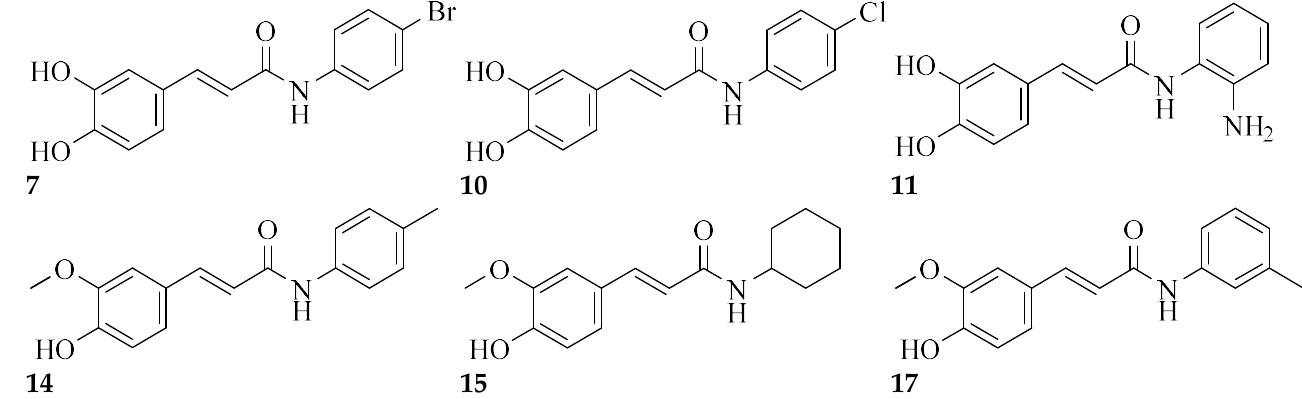
Figure 9. The effect of FA and its derivatives on the expression of MMP-2 and MMP-9 genes by RT-qPCR. The results were represented as mean of fold changes ± SD. β-actin gene was used as a control gene. *** Significant from FA at p < 0.001.